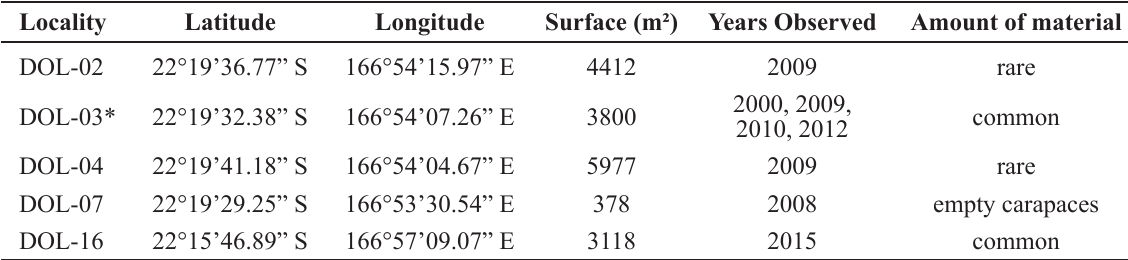
Table 1. The five localities in the southern part of New Caledonia from where Lynceus insularis new species is known. Information on sampling dates, geographic position, and size of locality (surface m²) is included. The material used from this study is from locality DOL-03 (type